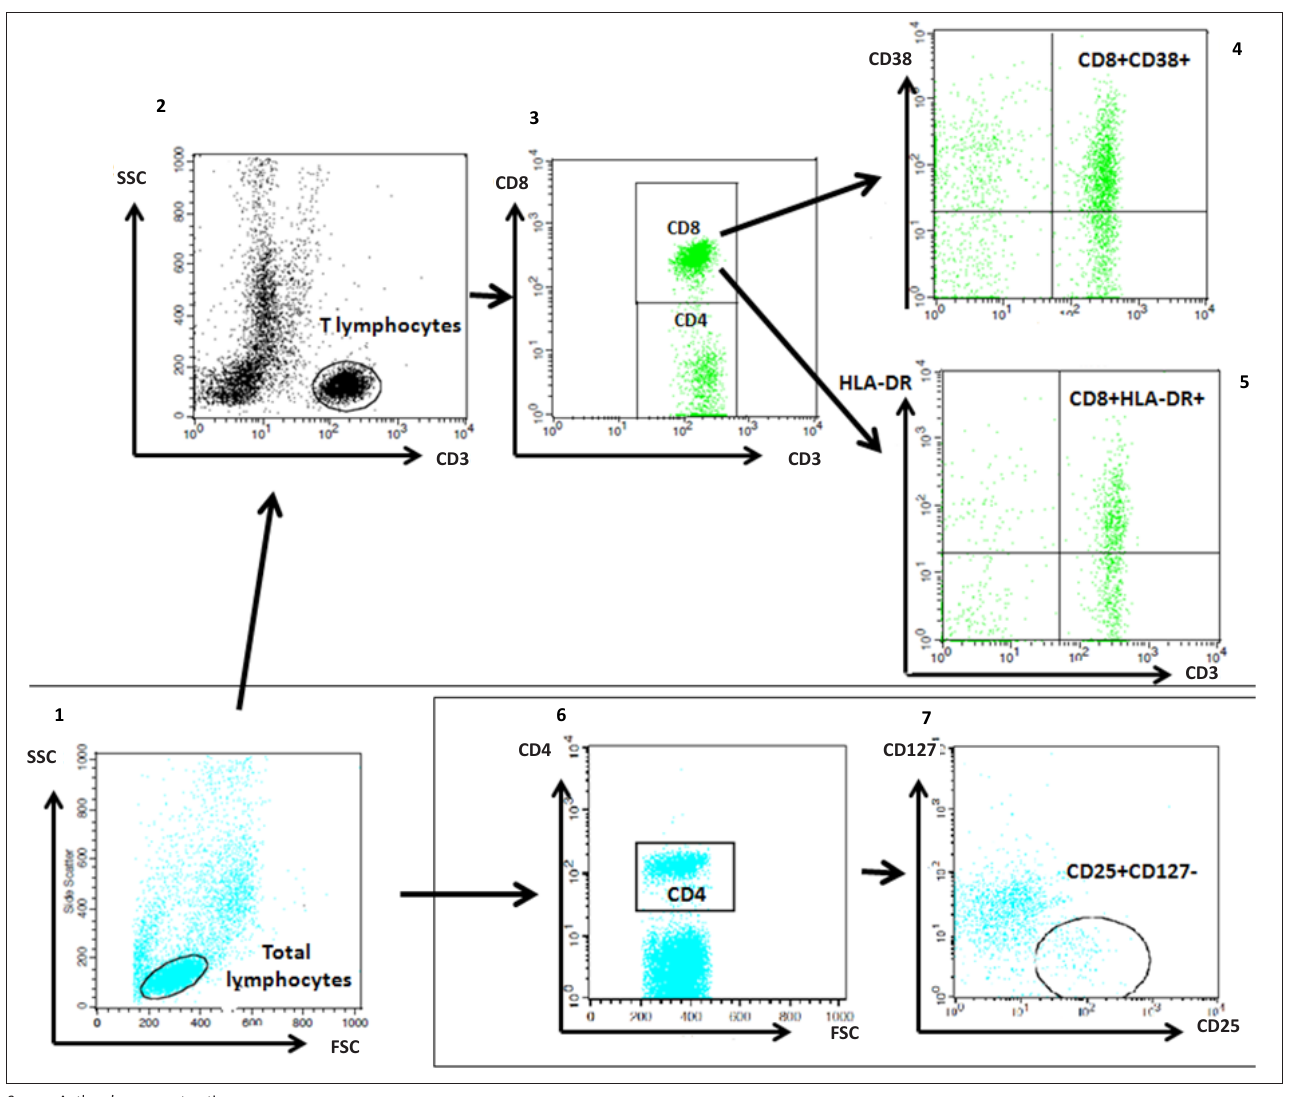
FIGURE 2: Gating strategy for assessing T-cell activation markers and regulatory